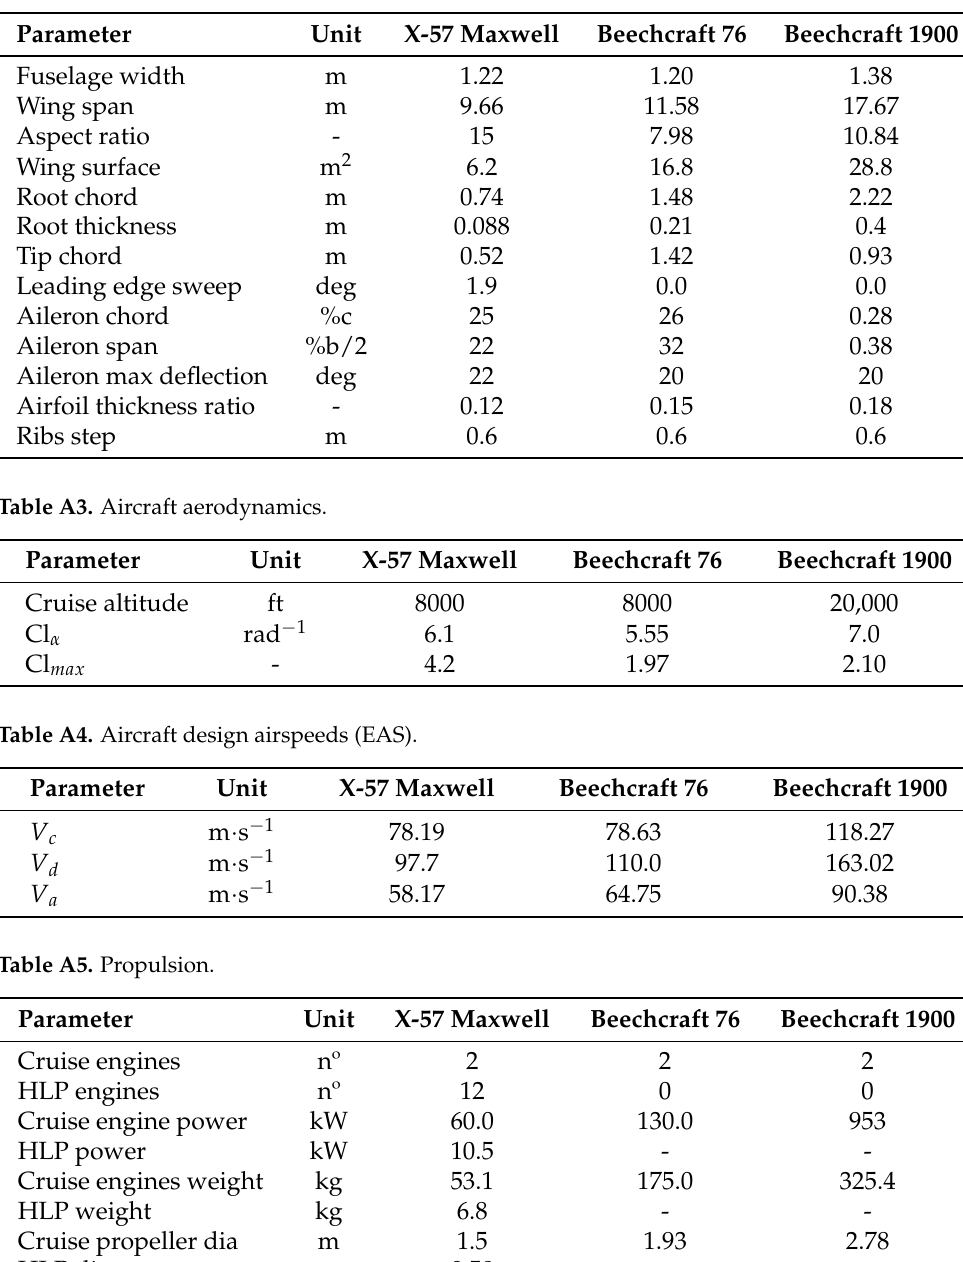
Table A2. Aircraft geometry.